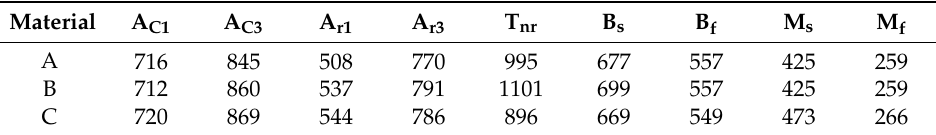
Table 2. The calculated temperatures of phase transformations ( ◦